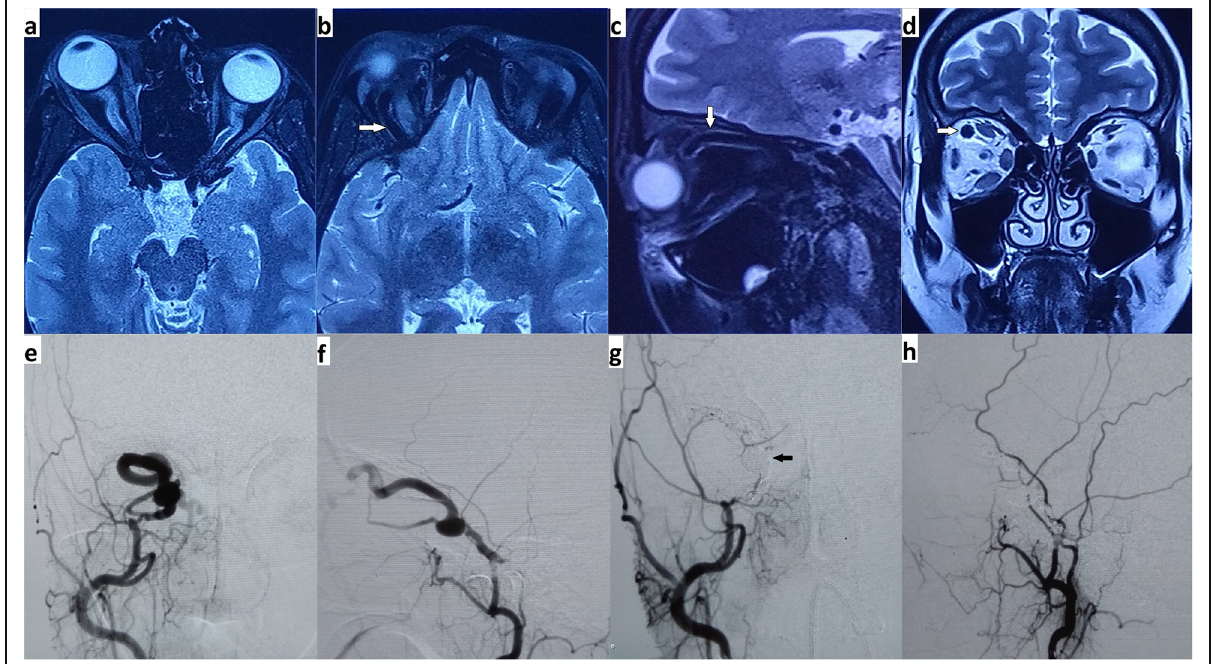
Fig. 1 MRI T2WI in axial plane ( a ) at mid-orbit level shows mild proptosis on the right side and ( b ) at the level of superior rectus muscle; ( c ) sagittal and ( d ) coronal planes show dilated right SOV (white arrow). Right ECA DSA images in AP ( e ) and lateral ( f ) projections show type C indirect CCF with dilated retrogradely filling right SOV. Post coiling DSA images in AP ( g ) and lateral ( h ) projections show coil mass (black arrow) occluding the fistulous connection, the venous pouch, and adjacent segment of right